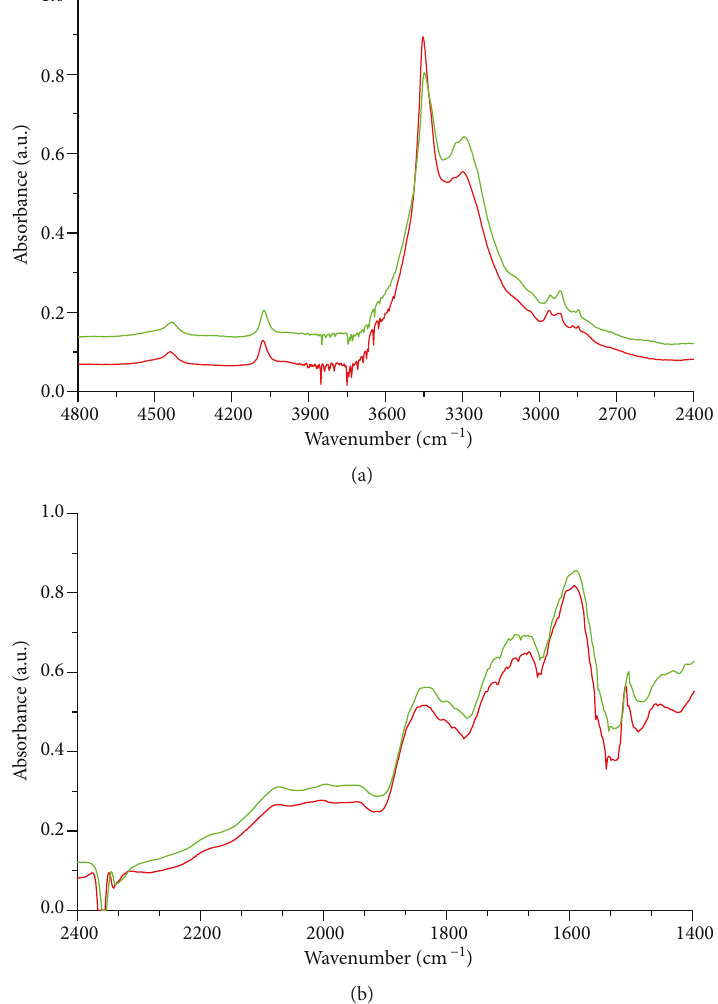
Figure 2: Micro-FTIR spectra of Figure 1 (red line) compared with that on the same crystal after heating at 100 ° C (green line) in the 4800 – 2400cm − 1 region (a) and in the 2400 – 1400 cm − 1 range (b).